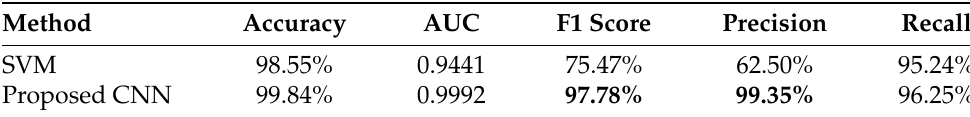
Table 7. Sensor fault detection performance compared to a baseline.